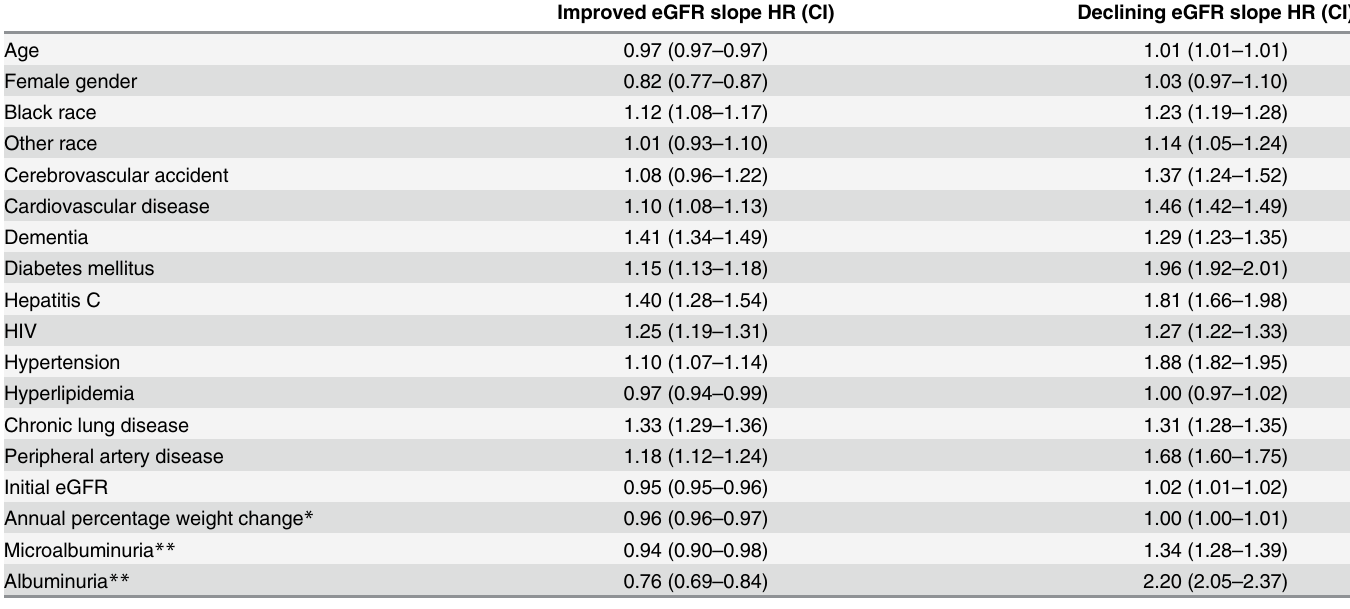
Table 3. Adjusted associations of improved eGFR slope, and declining eGFR slopes. Model adjusted for age, race, gender, diabetes mellitus, hyper- tension, cardiovascular disease, hyperlipidemia, peripheral artery disease, cerebrovascular disease, chronic lung disease, hepatitis C, HIV, dementia, and initial eGFR. Reference group is patients with stable eGFR